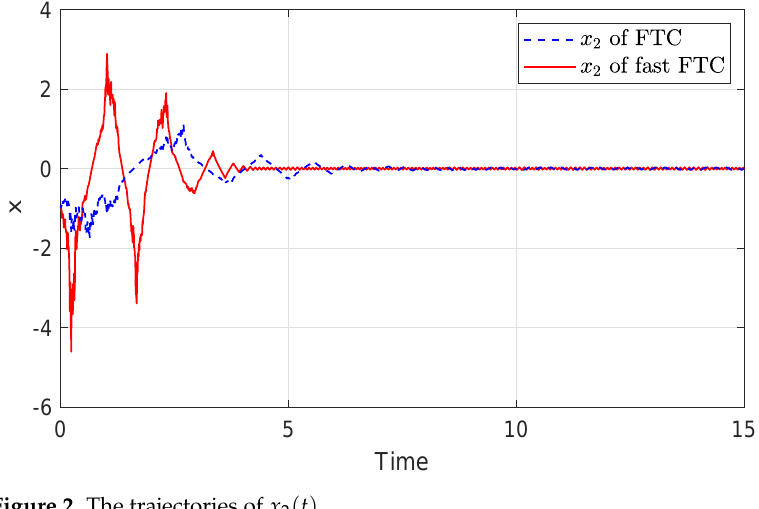
Figure 2. The trajectories of x 2 ( t ) .